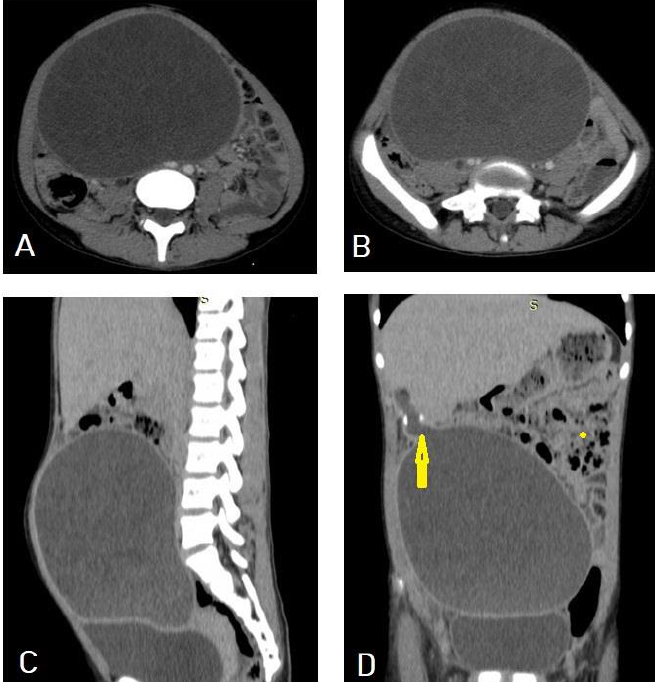
Figure 18. Selected CT images of a 13-year-old patient presenting with abdominal distention and feeling mass showing about a 16 × 15 × 11 cm well-circumscribed, multiloculated cystic lesion in the right side of abdominal and upper pelvic cavities as seen in axial ( A , B ) sections, exerting mass effect in the form of bilateral mild hydronephrosis, displacing the bowel loops laterally, and compressing the urinary bladder as seen in the sagittal ( C ) and coronal ( D ) sections. The cyst had a narrow neck-like (arrow) at the superolateral aspect connected with other cystic lesions in segment-VI of the liver. The above findings are in keeping with a large abdominal hydatid cyst.